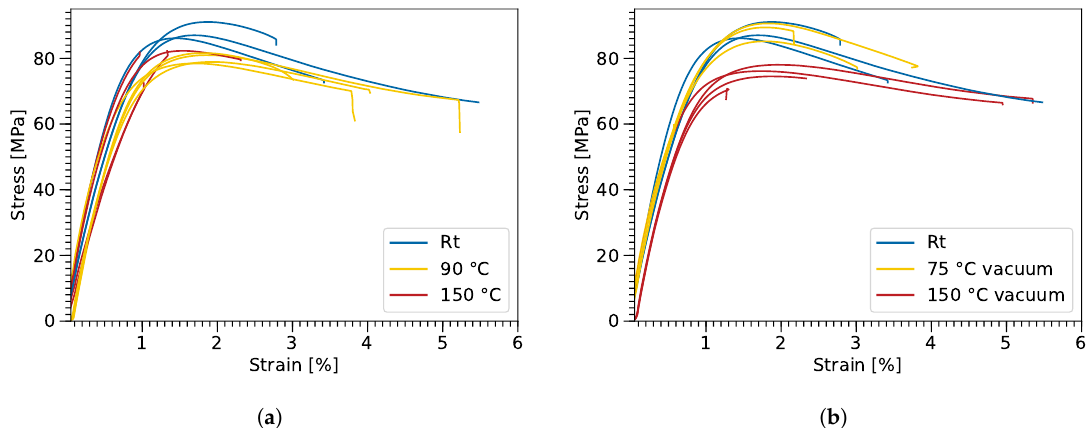
Figure 4. Stress-strain diagrams for the bulk samples after thermal exposure for 48 h under oxygen influence ( a ) and in vacuum conditions ( b